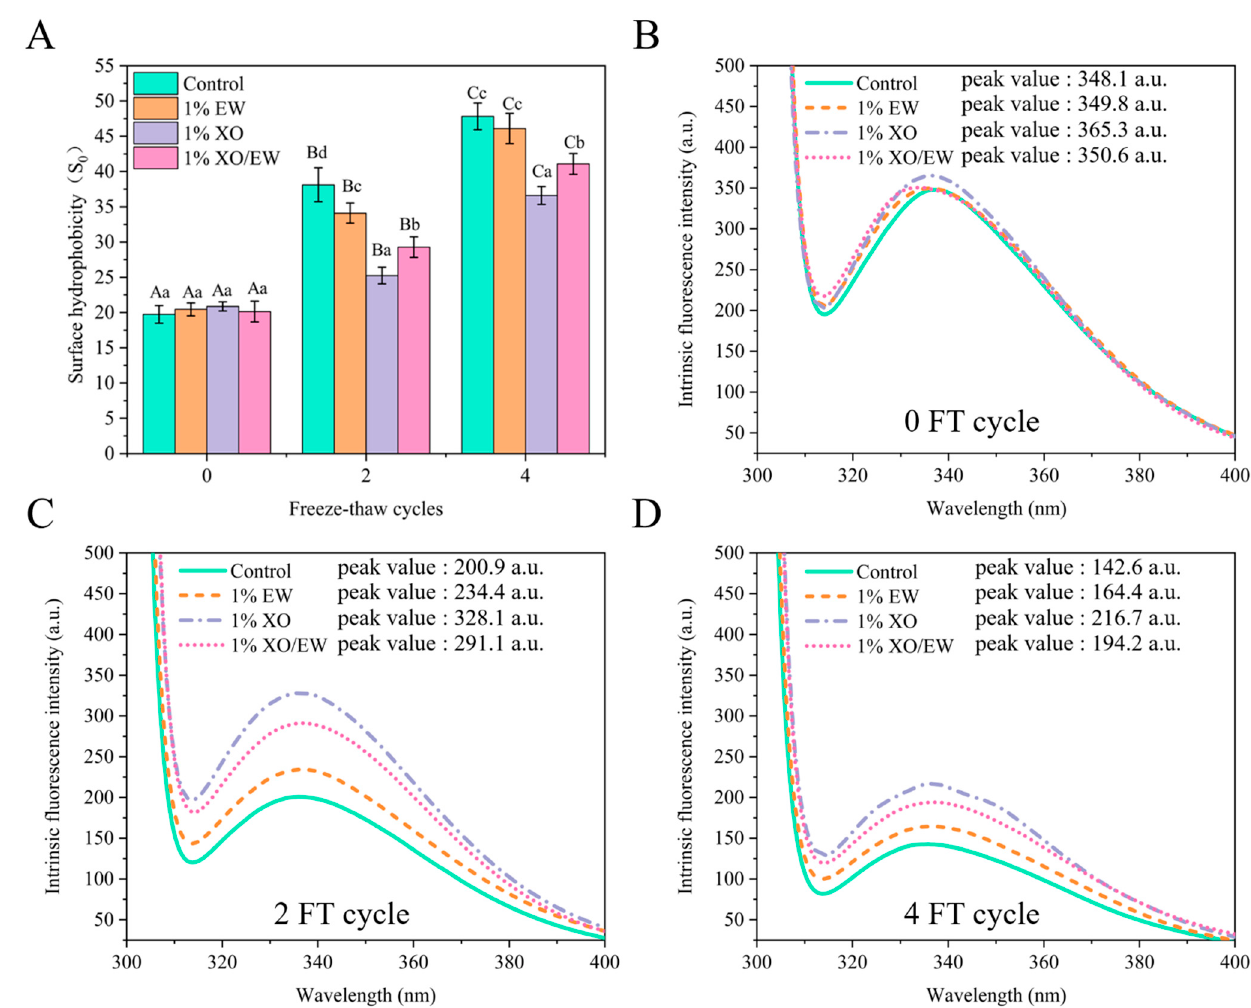
Figure 1. Change of surface hydrophobicity (S 0 ANS) ( A ) in Culter alburnus myofibrillar protein added with EW, XO, or XO/EW during freeze–thaw cycles (mean ± SD, n = 3). The control group (Control) was not added with EW, XO, or XO/EW. Capital letters indicate a significant difference ( p < 0.05) between different freeze–thaw cycles within the same treatment group. Lowercase letters indicate a significant difference ( p < 0.05) between different treatment groups in the same freeze-thaw cycle. Changes of intrinsic fluorescence intensity in Culter alburnus myofibrillar protein added with EW, XO, or XO/EW after 0 ( B ), 2 ( C ), and 4 ( D ) freeze–thaw cycles. The control group (Control) was not added with EW, XO, or XO/EW.